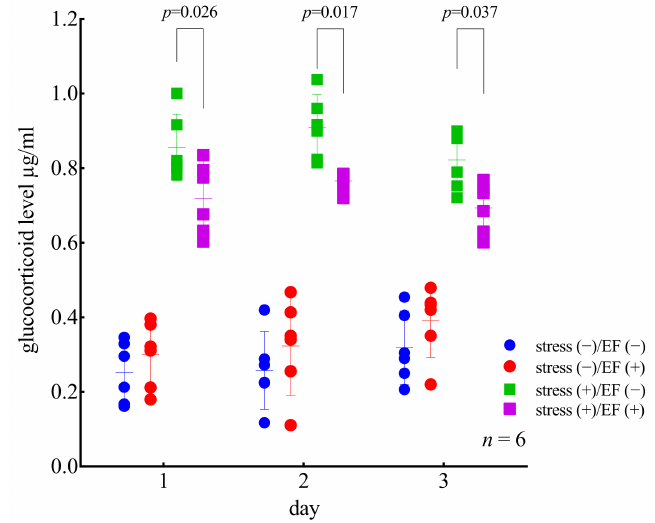
Figure 5. Effect of repeated immobilization on plasma GC level and effect of EF on the immobilization- induced increase in plasma GC level, Experiment 1. As determined using a three-way ANOVA, for the main effect, for “day”, F (DFn, DFd) = F (2, 60) = 0.8763, p = 0.4216. The effect is therefore considered not significant. For “stress”, F (DFn, DFd) = F (1, 60) = 554.2, p < 0.0001. For “sham/EF”, F (DFn, DFd) = F (1, 60) = 3.193, p = 0.079. For the “day × stress” interaction, F (DFn, DFd) = F